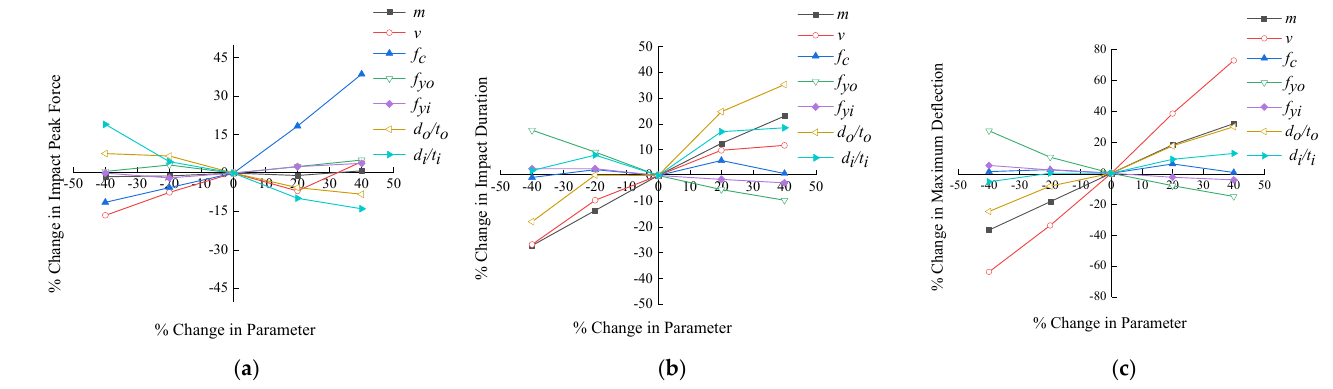
Figure 11. Sensitivity of H-DS corresponding to changes in structure-related variables. ( a ) Peak impact force; ( b ) Impact duration; ( c ) Maximum deflection. From Figure 12, for S-DS columns, the compressive strength and impact velocity of concrete have the greatest influence on the peak impact force; the outer steel tube, the diameter–thickness ratio of the inner steel tube and the compressive strength of concrete have the greatest influence on the impact duration; and the impact velocity, impact mass and the diameter–thickness ratio of the outer steel tube have the greatest influence on the peak deflection.